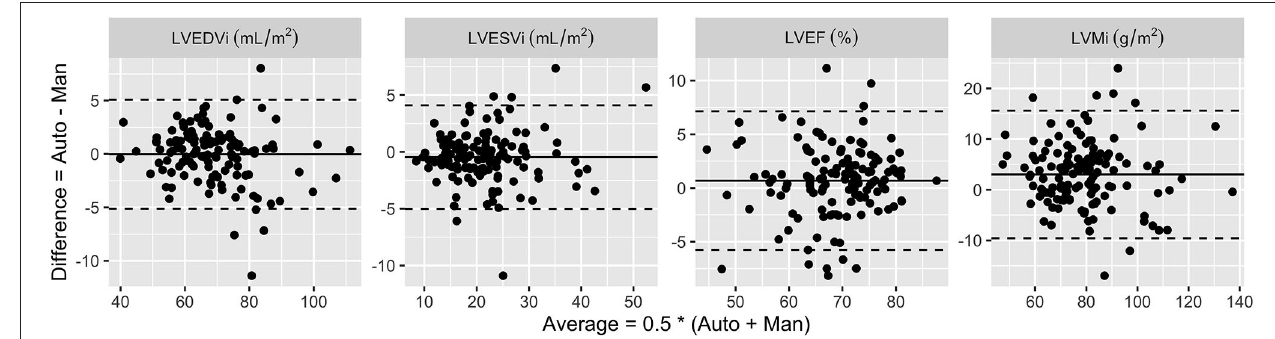
FIGURE 6 | Differences between automated analysis (Auto) and manually drawn contours (Man). Solid lines are mean differences and dashed lines are the limits of agreement within ± 1.96 × standard deviation from the mean. The mean difference values are shown in Table 5 .